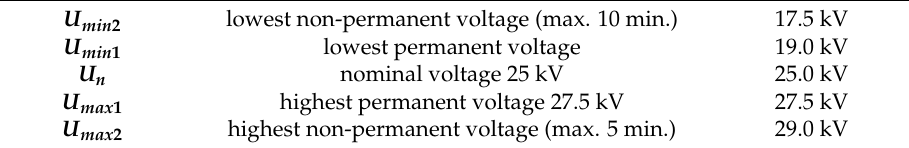
Table 1. The 25 kV system operating voltages